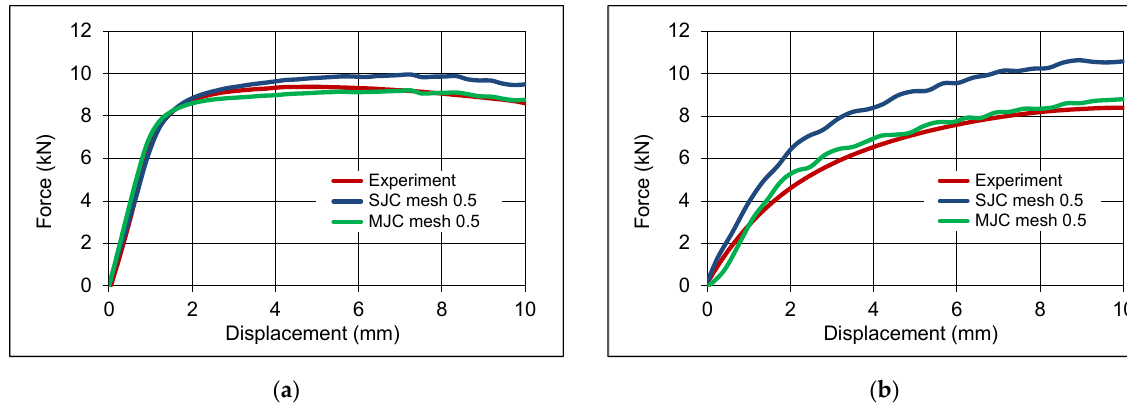
9 Figure 10. Maximum force of SJC, MJC and experiment. For the first bending, both models show good agreement with the experiment. How- ever, for the reverse bending, the calculated force in the simulation according to the SJC